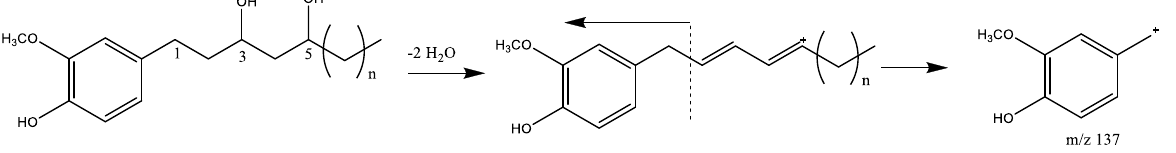
Figure 6. Fragmentation pathway for gingerdiol compounds 2 ( n = 6), 6 ( n = 8), 17 ( n = 10). A related group corresponds to dehydrogingerdiones. Peaks 19 (Rt = 22.53 min), 27